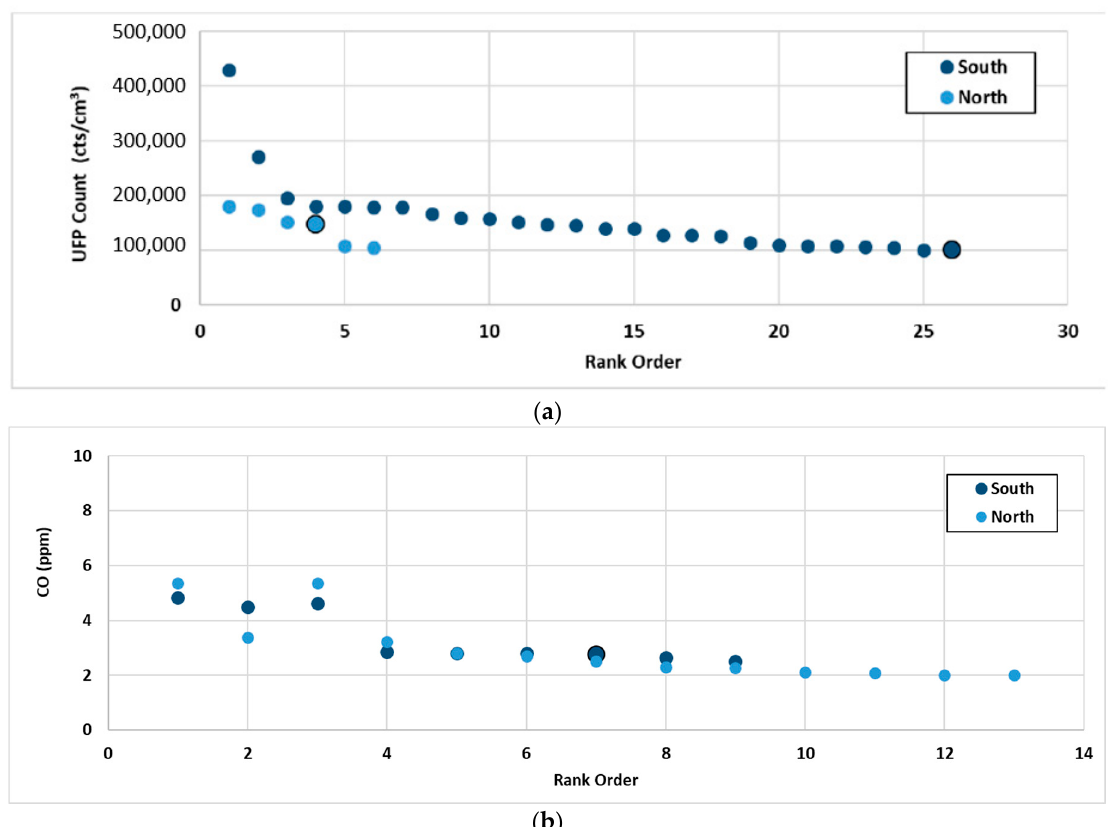
Figure 5. Rank order of largest peaks in concentration for the morning commute for ( a ) UFP and ( b ) CO. Large markers indicate peaks that have occurred in the afternoon—all of the rest occurred in the morning.